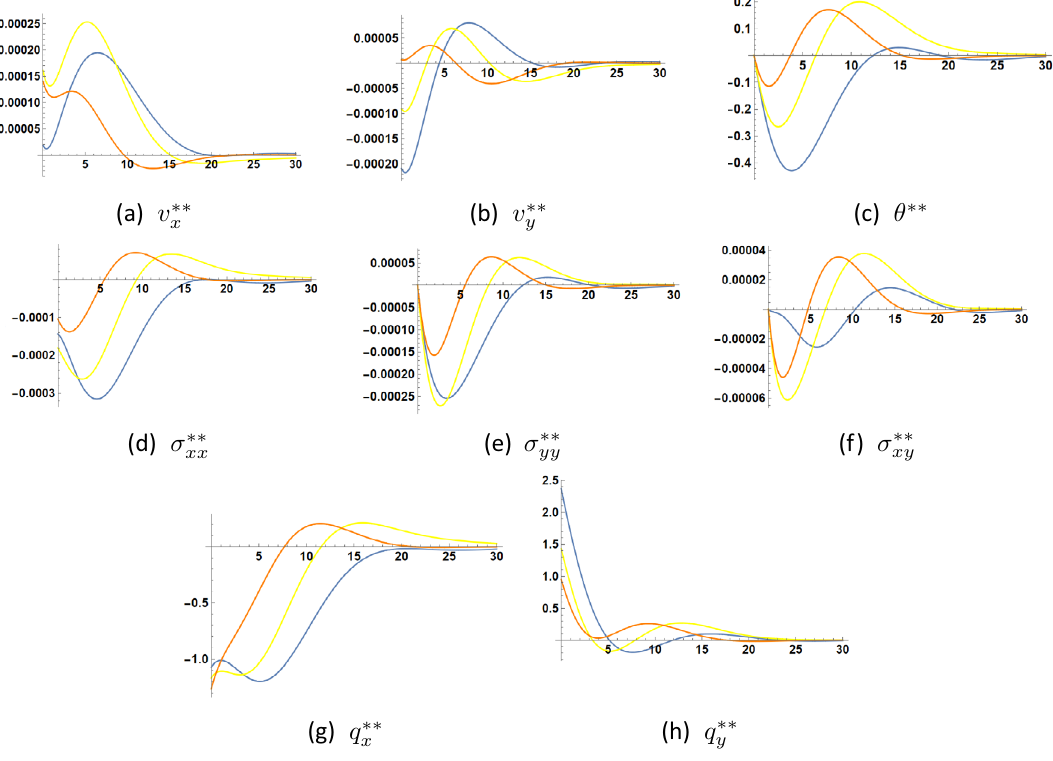
Figure 6. Second order solution as function of y at x = 0.1 , t = 1.5 for τ q = 0.6 and three values of τ θ • τ θ = 0.1 τ θ = 0.3 τ θ = 0.5 • •